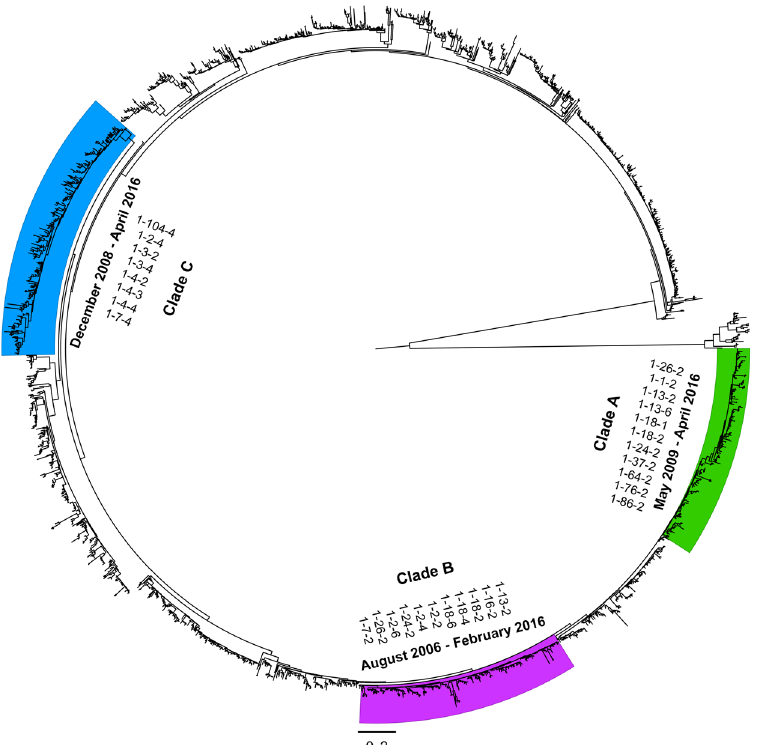
Figure 2. Maximum Likelihood (ML) phylogeny of PRRSV ORF-5 sequences collected between January 1998 and April 2016 in swine farms in the Midwest of the U.S. The ML tree was inferred from the GTR + Γ model of evolution. Support given at nodes based on through bootstrap search using 10 runs, with 100 ML replicates in each run, implemented in RAxML version 8. The scale bar indicates the number of substitutions per site. Selected clades are highlighted with green (Clade ‘A’), purple (Clade ‘B’), and Blue (‘F’), with their corresponding RFLP-types isolates listed and collection dates